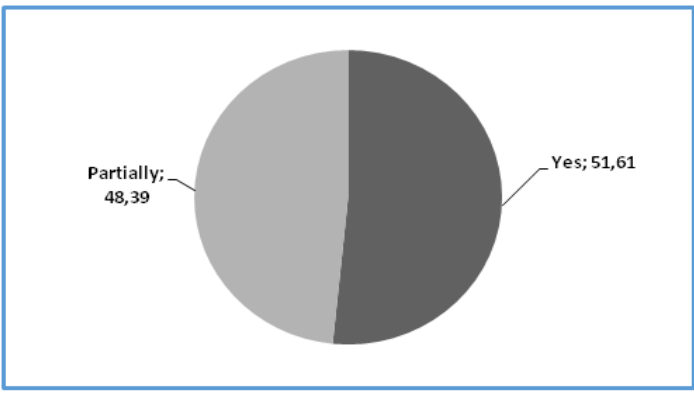
Fig. 3. Percentage of responses concerning mediation between learner and